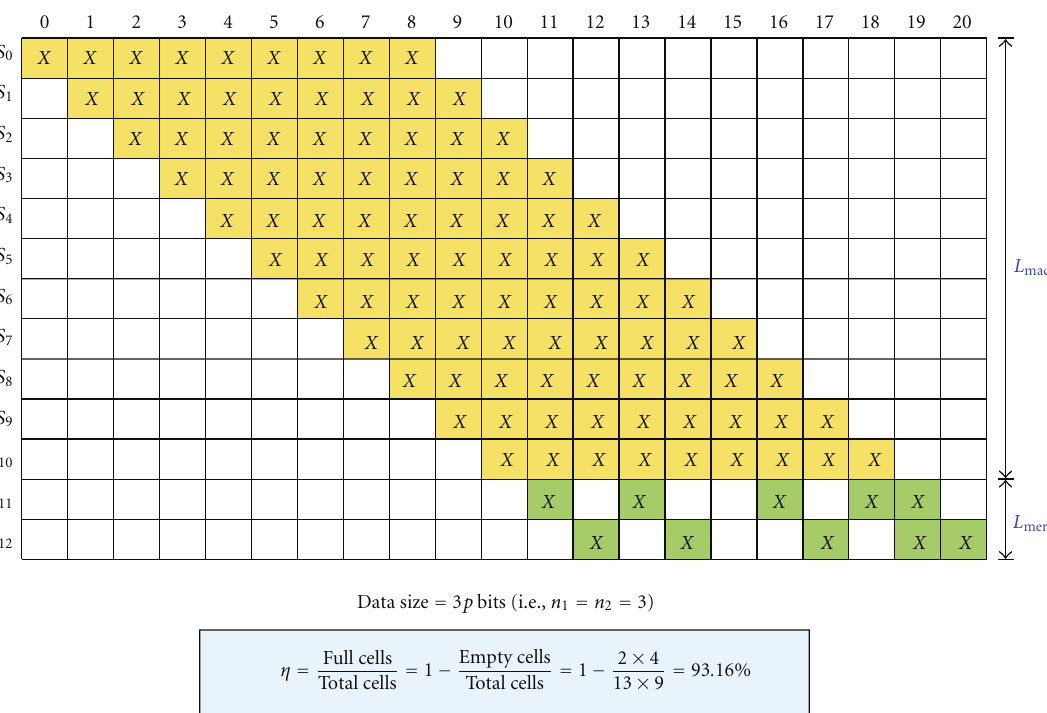
Figure 9: Example pipeline reservation